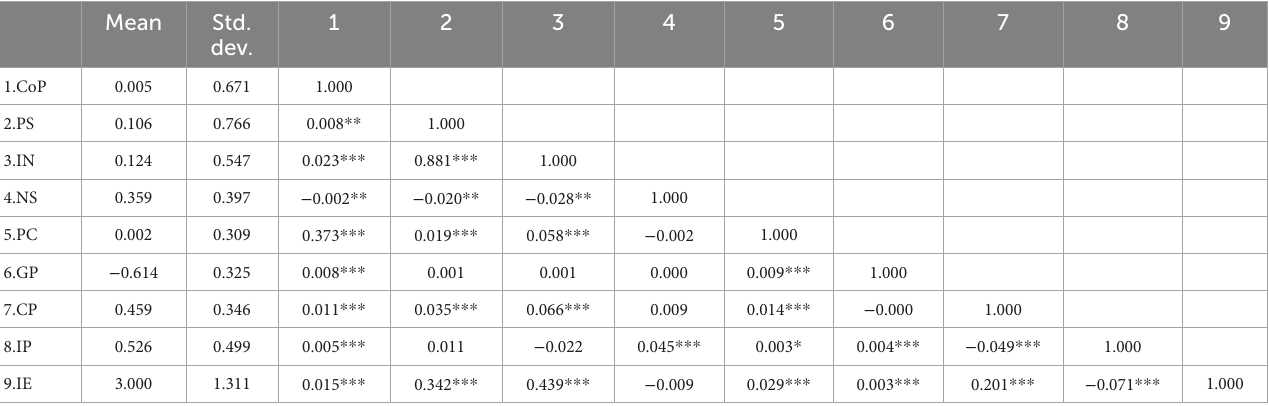
TABLE 1 Descriptive and correlation statistics.